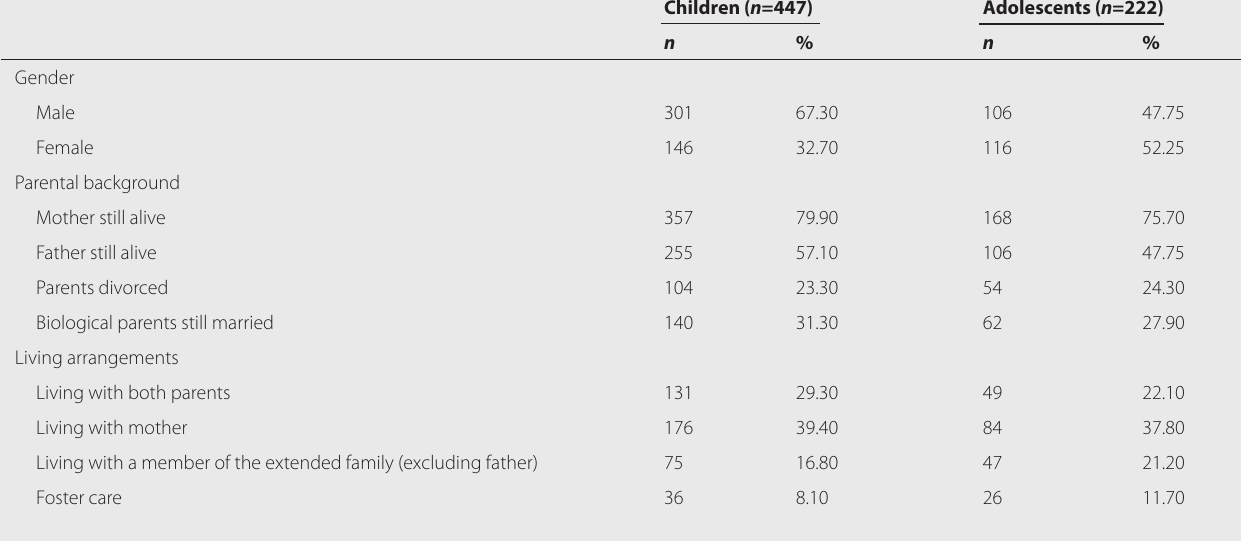
Table 1. Gender, parental background and living arrangements of children and adolescents seen at the Child and Adolescent Unit of the FSPC from January 2006 to December